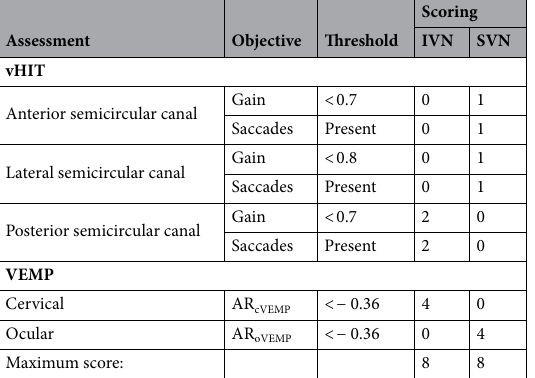
Table 1. Scoring thresholds for determination of the most affected nerve of